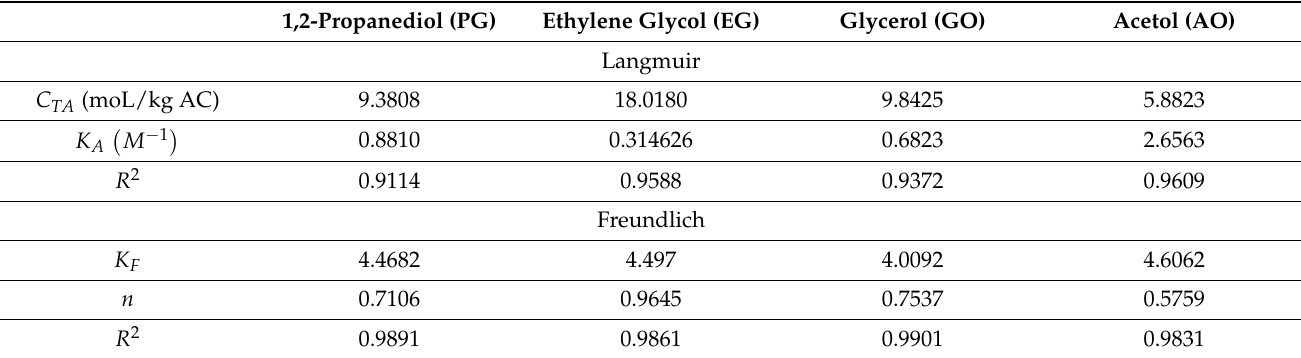
Table 3. Langmuir and Freundlich isotherm coefficients for 1,2-propanediol, ethylene glycol, glycerol and acetol on activated carbon.